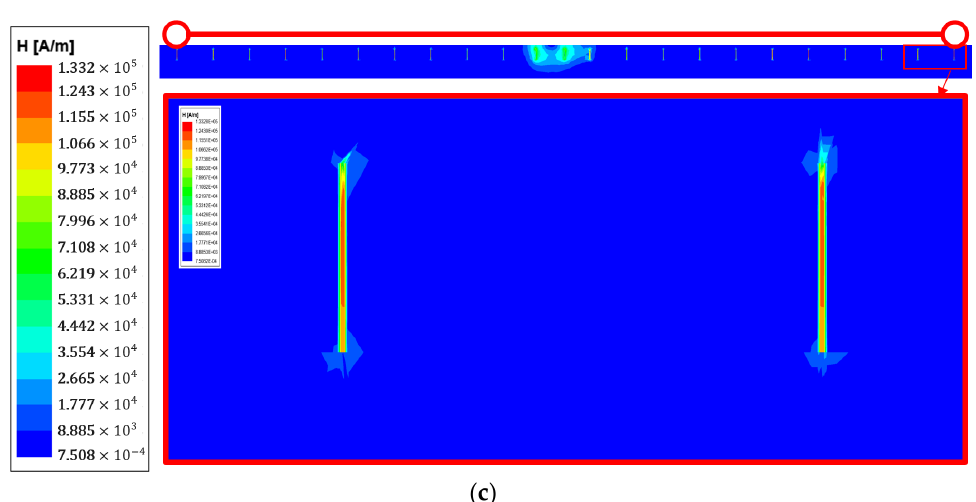
Figure 13. Magnetic field distribution diagram of bifilar-spiral type: ( a ) the magnetic field distribution, ( b ) the strength of the magnetic field, ( c ) the distribution map of the magnetic field generated from some superconducting wires.